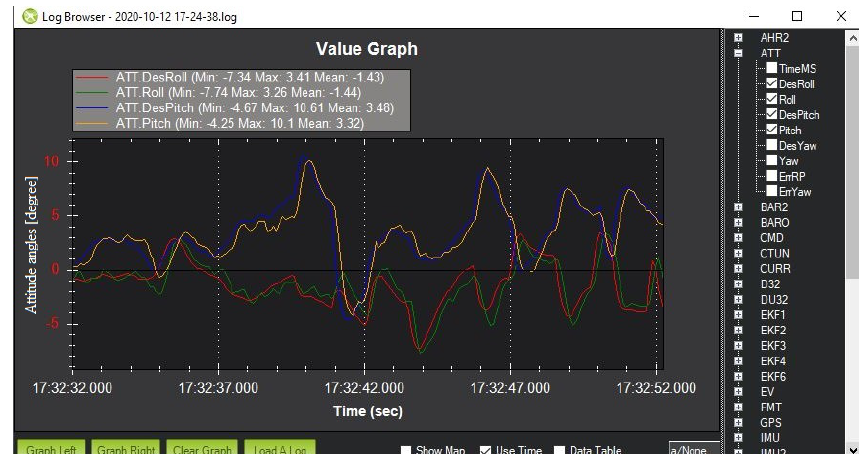
Figure 12. Logged flight data.